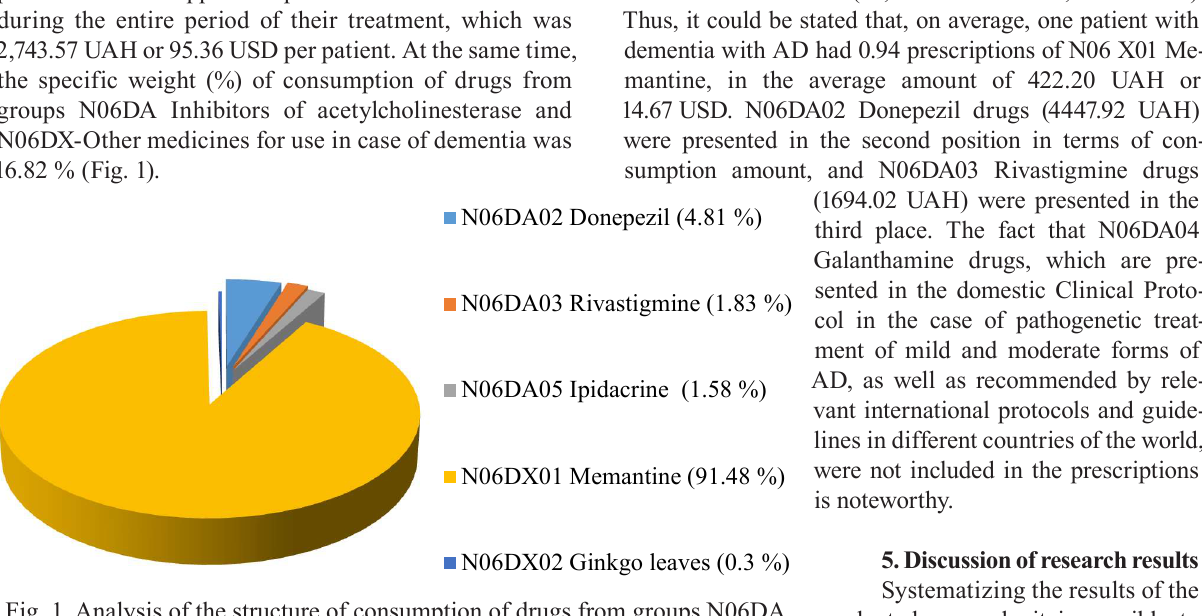
Fig. 1. Analysis of the structure of consumption of drugs from groups N06DA Inhibitors of acetylcholinesterase and N06DX-Other medicines for use by patients with dementia in